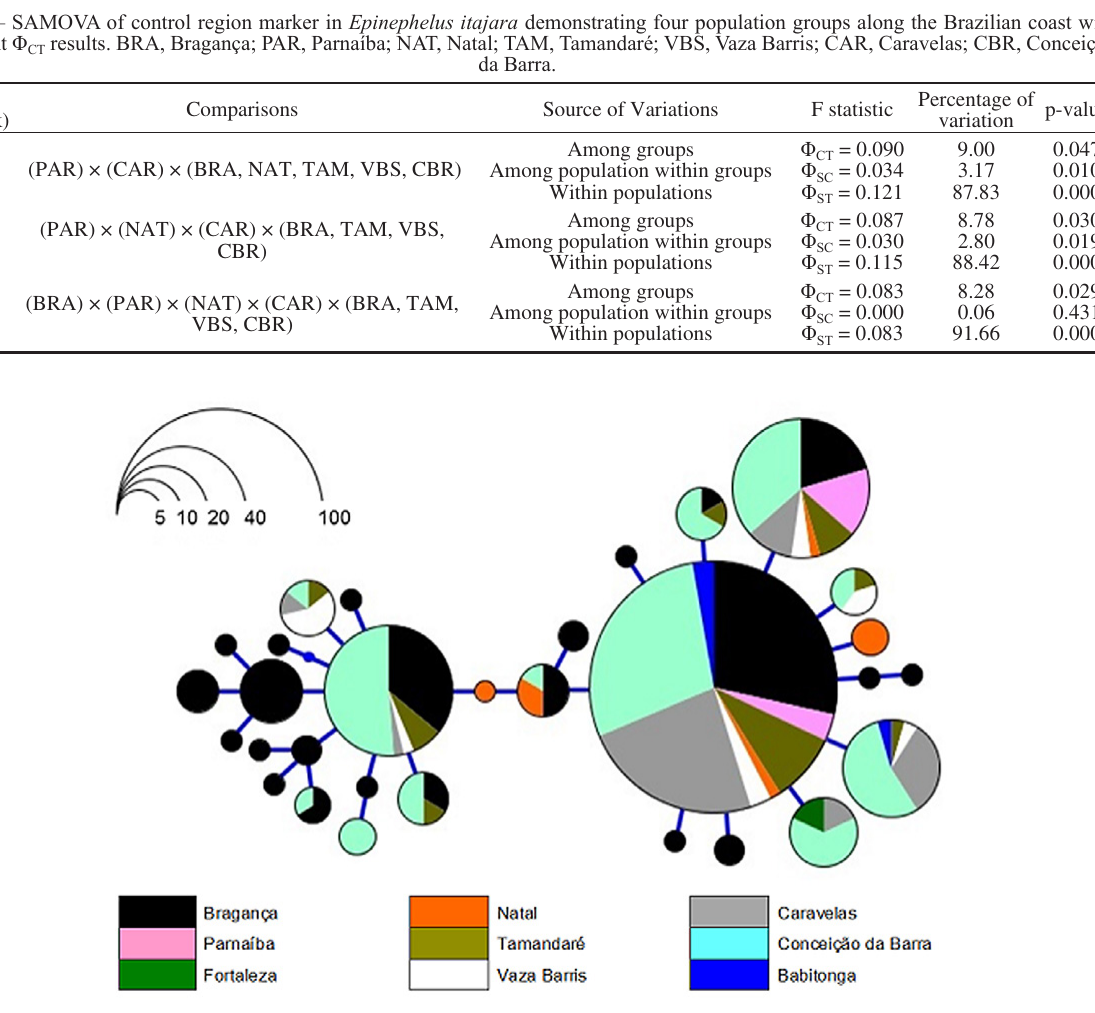
Fig. 2. – Haplotype network of control region of mtDNA for distant Epinephelus itajara population units on coast of Brazil. Continuous line: one mutational step. Blue circle: adding more mutational